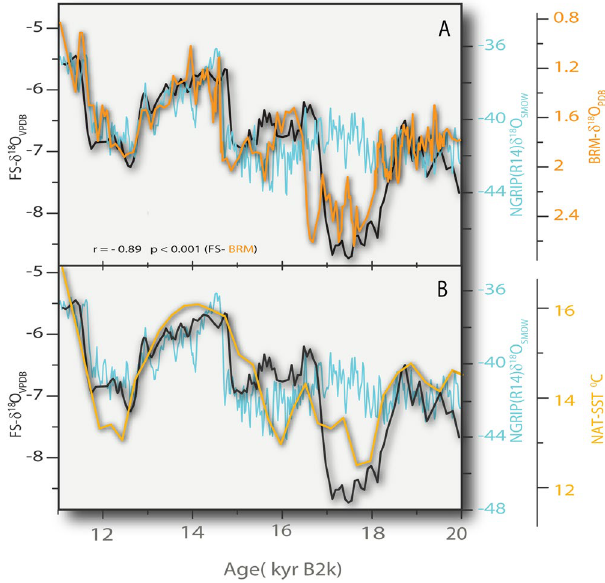
Figure 4. ( A ) A comparison between FS-AH1 δ 18 O data (FS; black curve), the Bermuda Rise - δ 18 O data (orange line) 4 and NGRIP δ 18 O time-series (blue curve) 5 . The FS-AH1 and the Bermuda Rise δ 18 O data show remarkable correlation (r = − 0.89 p < 0.001) during the period shown here, covering the ECR and HS1, associated with a weakened AMOC 4 . ( B ) Comparison of FS-AH1 δ 18 O data to another North Atlantic δ 18 O record, MD952042 off the Iberian margin (yellow curve) 1 showing the similarity between the FS-AH1 δ 18 O and and the SST reconstruction for the North Atlantic during the period of the ECR and HS1 1 .